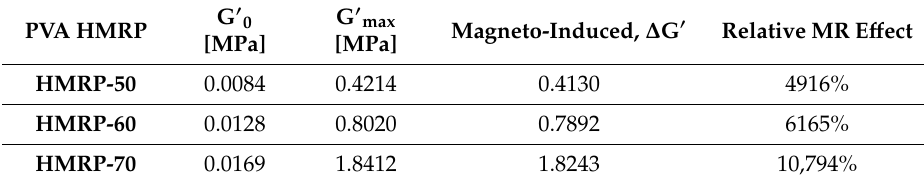
Table 3. The initial storage (G (cid:48) 0 ), maximum storage (G max ), magneto-induced storage modulus ( ∆ G (cid:48) ) and relative MR e ff ect values of PVA HMRP